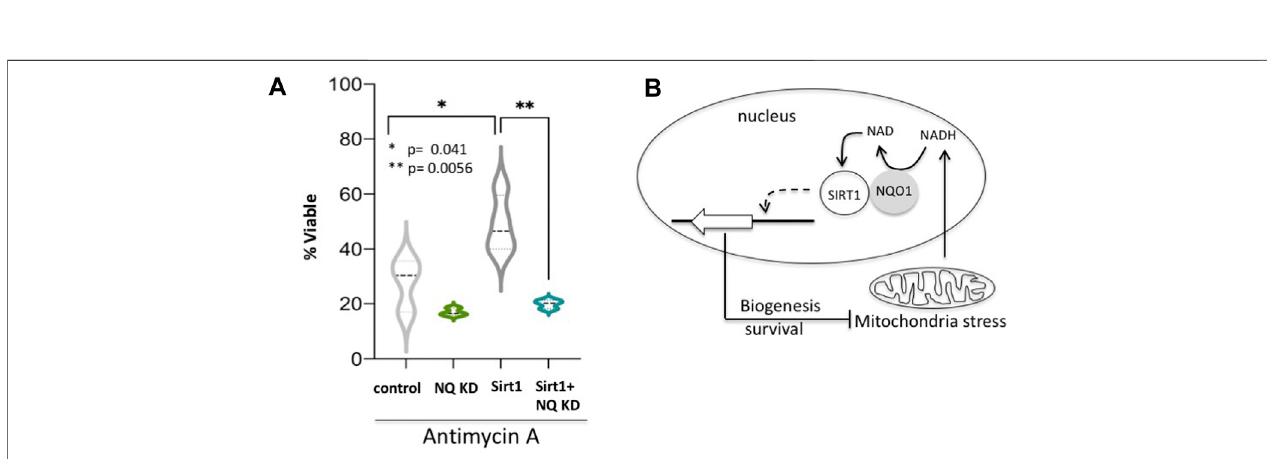
FIGURE 5 | NQO1 supports SIRT1 regulated gene expression under mitochondrial inhibition. (A) The interplay and the reported mechanism of NQO1-SIRT1 and PGC-1 α under mitochondrial stress are schematically presented. (B – D) The mRNA levels of the SIRT1 regulated genes Glut4 (B) Pdk4 (C) and TGFB2 (D) were examined in NIH3T3 cells stably over expressing an NQO1 targeting shRNA or a control shRNA following treatment with indicated concentrations of rotenone (rot) or antimycin A (AntiA) for 16 h. Statistical signi fi cance was analyzed by conducting two-tailed unpaired t-test. * p < 0.05, ** p < 0.01, *** p < 0.001.